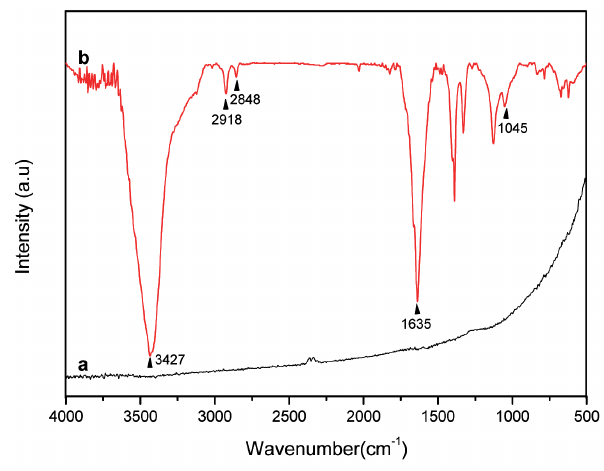
Figure 1. FTIR spectrum of (a) pristine MWNT and (b) amino- functionalised MWNT. Footnote: MWNT treated with a mixture of concentrated H 2 SO 4 and HNO 3 (v/v 3:1), and refluxed at 120 u C. After cooling to room temperature, the mixture was vacuum-filtered on a 0.2 mm pore Polytetrafluoroethylene membrane. The oxidised nano- tube was washed in a NaOH solution. Finally, the product was